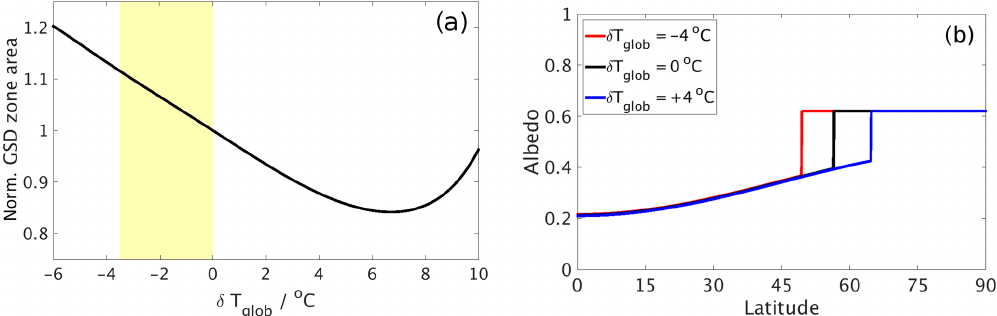
Figure 2. (a) Normalized GSD zone area fraction as function of global mean temperature deviation from PI climate conditions. The yellow bar marks the region between LGM and PI. (b) Latitude dependence of albedo for three different deviations from the global mean temperature ( − 4, 0 and 4 ◦ C). Note that poleward of the snow line the albedo is 0.62 (albedo of snow/ice-covered area).